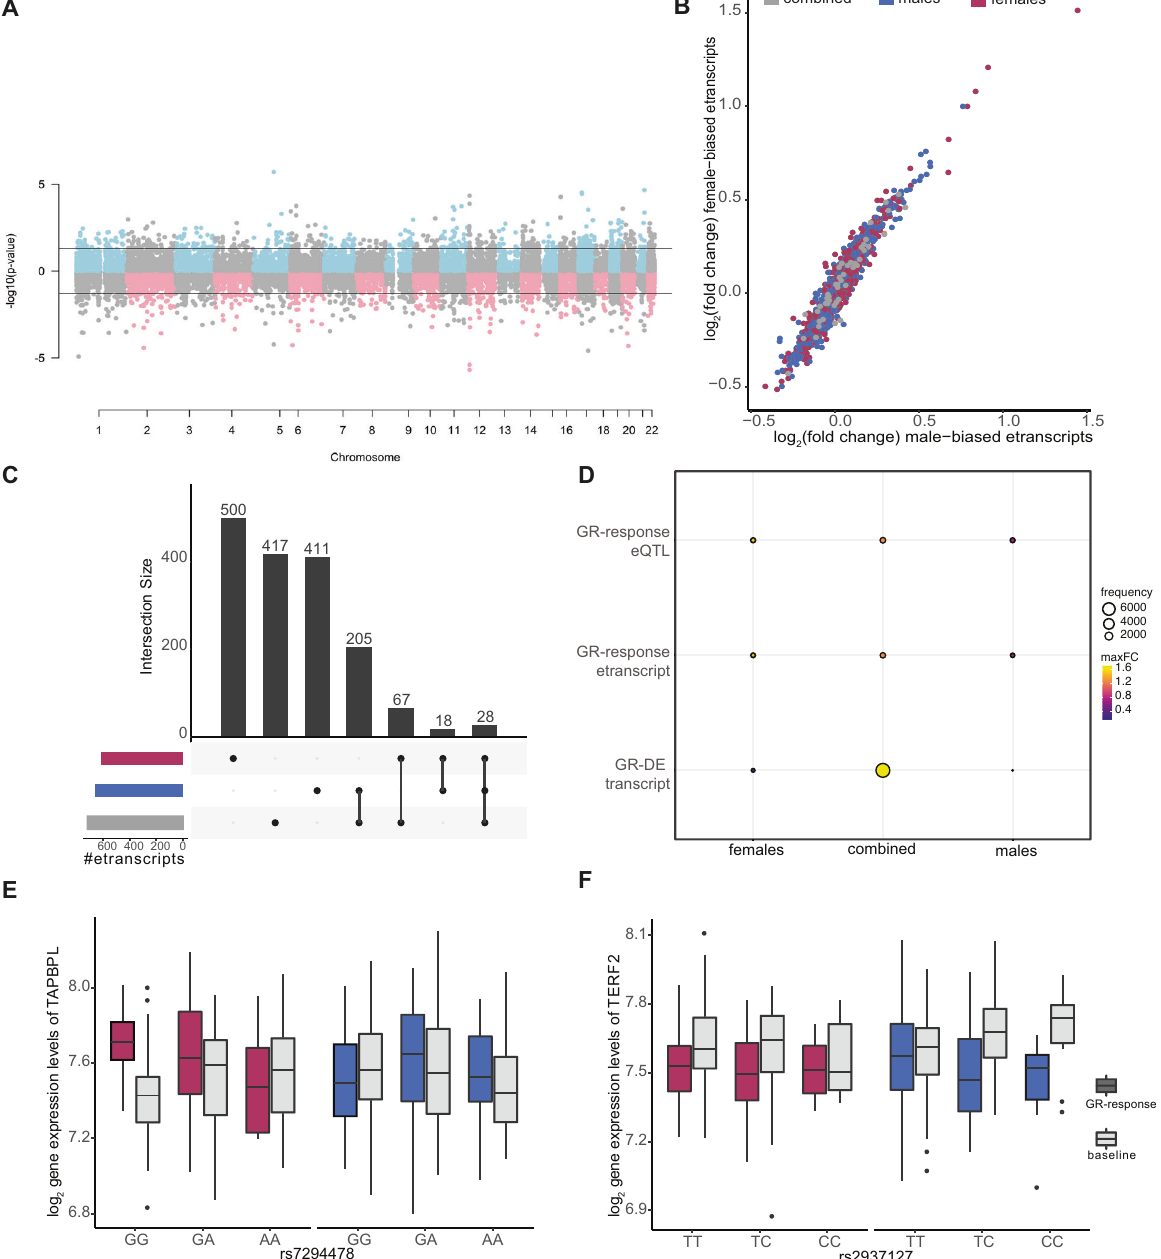
Fig. 3 GR-response cis -eQTL analyses results. GR-response cis -eQTL analyses: A Miami plot of eQTL results. Only the best eQTL per etranscript is plotted. Dashed lines indicate signi fi cance cut-off at an FDR of 5%. B Mean log2 fold changes between post dexamethasone and baseline colored by identi fi cation of etranscripts in combined analysis ( n = 46 transcripts), females ( n = 567) or males ( n = 616). The effects of the etranscripts for male and females were similar (Wilcoxon p- value = 0.7). C Upset plot displaying the overlapping signi fi cant GR-response etranscripts identi fi ed in combined analysis, males, and females. The majority of these transcripts were speci fi c to females (91%, n = 193), whereas 68 (59%) transcripts were speci fi c to males and 74 (57%) transcripts were found in the combined eQTL analysis. D Balloon plot showing the frequency of transcripts found in (1) females but not the combined analysis, (2) the combined analysis, and (3) males but not the combined analysis, across GR-DE transcripts, etranscripts, and etranscript-eSNP pairs. In the GR-DE analysis, the majority of transcripts are identi fi ed in the combined analysis, whereas etranscripts and eSNP pairs (eQTLs) show more of an even distribution across females, combined, and males. Maximum fold changes were higher in female etranscripts relative to males. E , F Boxplots of overlapping signi fi cant GR-DE transcripts and etranscripts. Gene expression is strati fi ed by eSNP and shown for females and males. E Tag eSNP rs7294478 is located in an intron of C1RL-AS1 on chromosome 12. However, the eQTL effect was observed only in females on TAPBPL expression, which is located over 700 kb downstream. TAPBPL itself is one of the signi fi cant DR-DE genes identi fi ed in females (FDR = 0.00068 vs. FDR = 1 in males). F The intronic tag eSNP rs2937127 demonstrates no effect in females, while in males the minor allele was associated with a down regulation of TERF2 gene expression (FDR = 0.04). TERF2 is located approximately 470 kb upstream of the tag eSNP, which is positioned in the gene WWP2